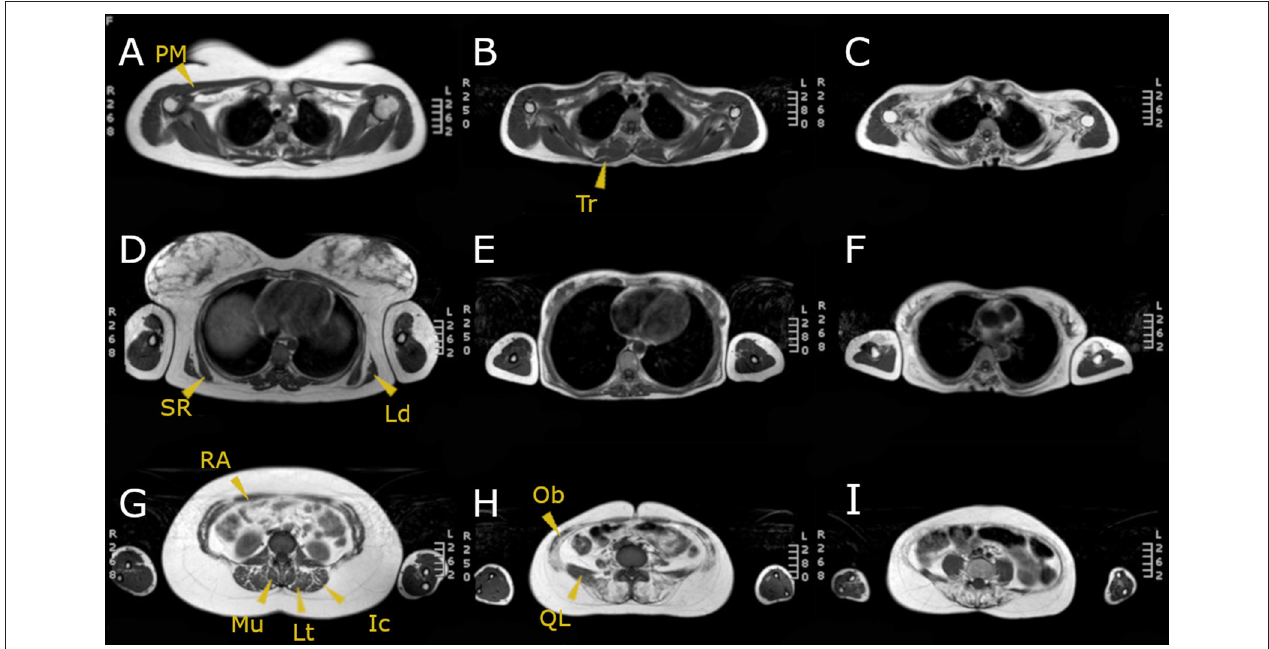
FIGURE 1 | MRI T1w of three LOPD patients: (A,D,G) correspond to a patient with mild involvement; (B,E,H) correspond to a patient with moderate muscular involvement; (C,F,I) correspond to a patient with severe muscular involvement. Yellow arrowheads point the muscles assessed. PM, pectoralis major; SR, serratus; Ld, latissimus dorsi; RA, rectus abdominis; Mu, multifidus; Lt, longissimus thoracis; Ic, iliocostalis; Tr, trapezius; Ob, obliquus externus and internus; QL, quadratus lumborum.